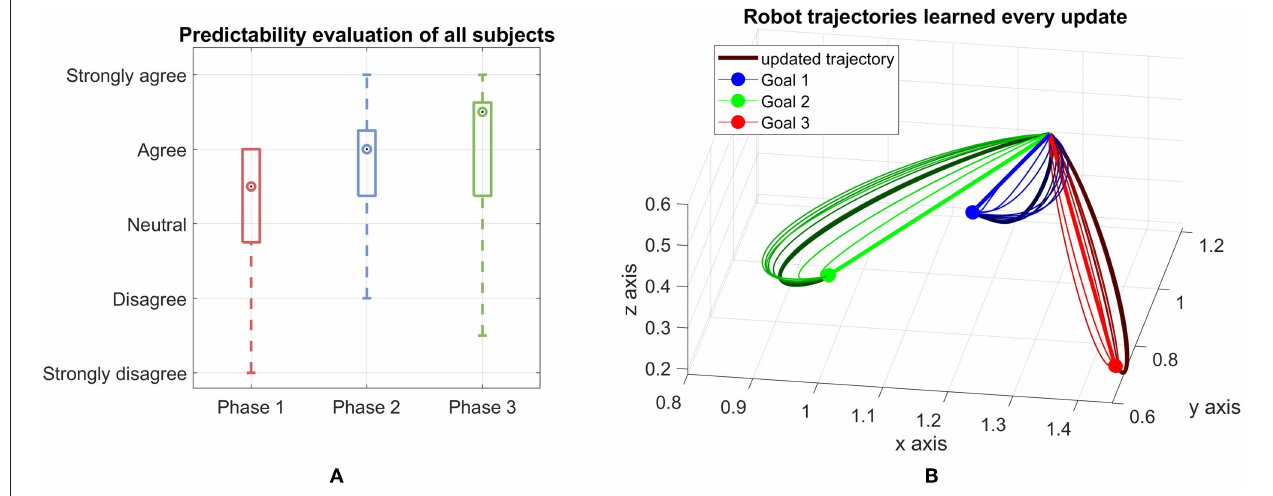
FIGURE 4 | (A) Predictability evaluation from all subjects for each phase. The evaluation of participants for the first 4 updates, then the next 3 updates and the last 3 ones are shown in phase 1, phase 2 and phase 3, respectively. The mark shows the median of each group. The box contains 50% of the middle half of all given answers thus representing the interquartile range of the data. The whiskers mark the most extreme answers. (B) Robot trajectories learned for each goal every update. The first updates (straight lines) and last updates are marked thicker than the